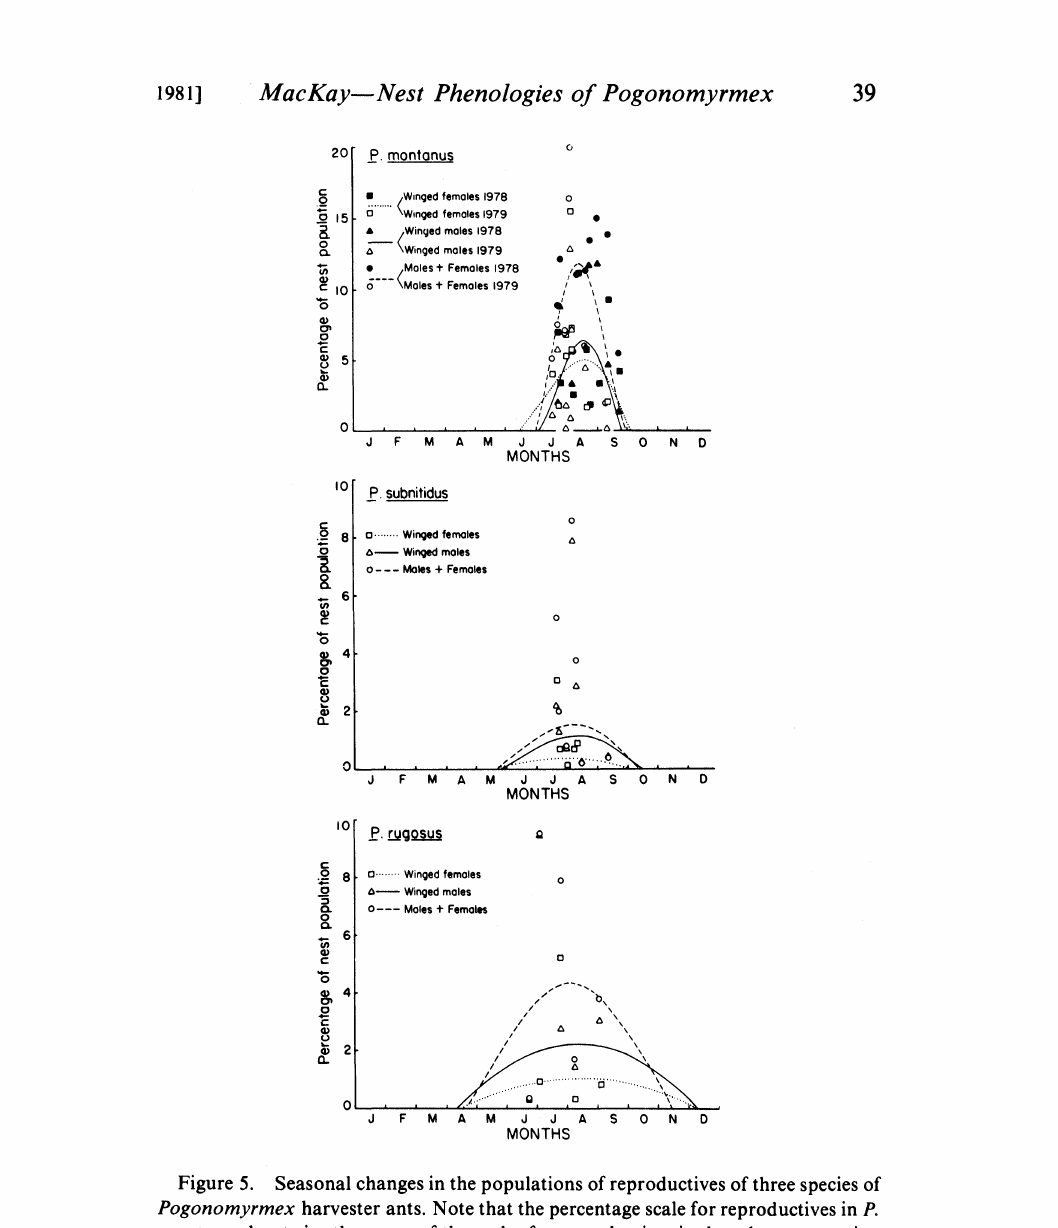
Figure 5. Seasonal changes in the populations of reproductives of three species of Pogonomyrmex harvester ants. Note that the percentage scale for reproductives in P. montanus has twice the range of the scales for reproductives in the other two